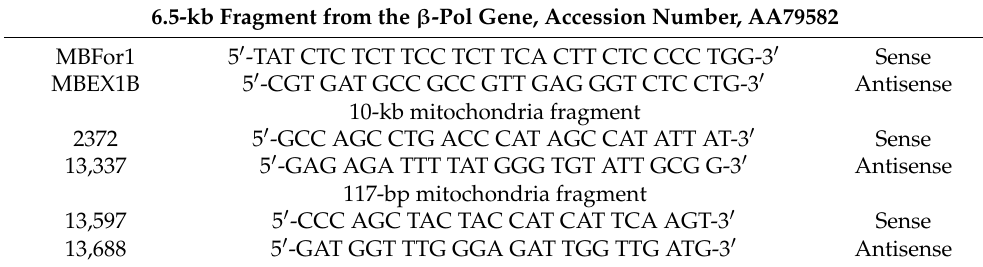
Table 2. Mouse Gene Targets and Primer Pairs for